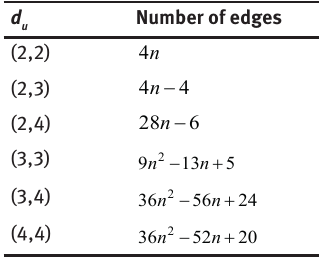
Figure 4: Plot of M-Polynomial of Dominating David Derived Network of first